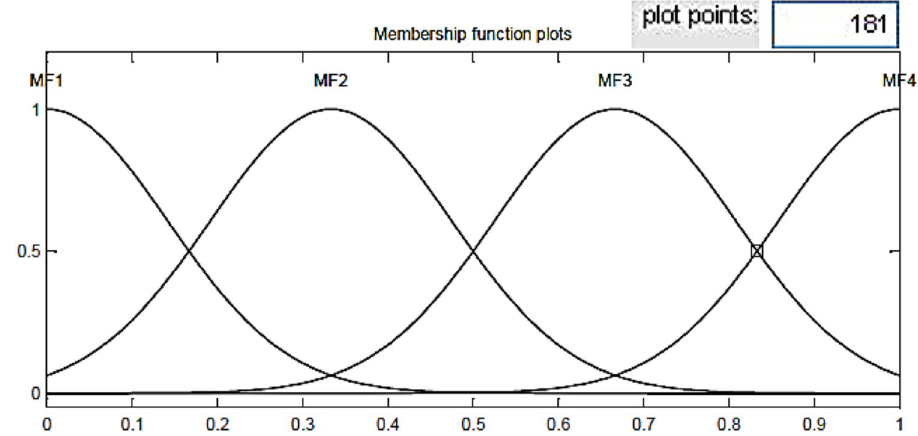
Fig. 6 Membership function